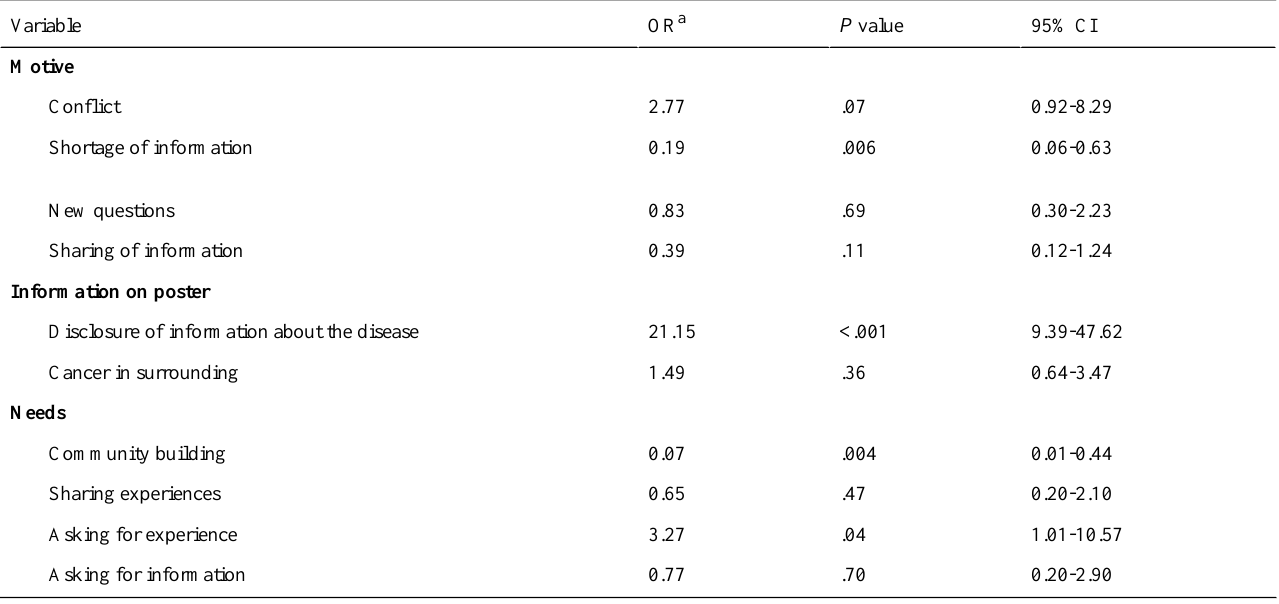
Table 4. Differences between posts containing signs of interpersonal convergence (reference category=mass